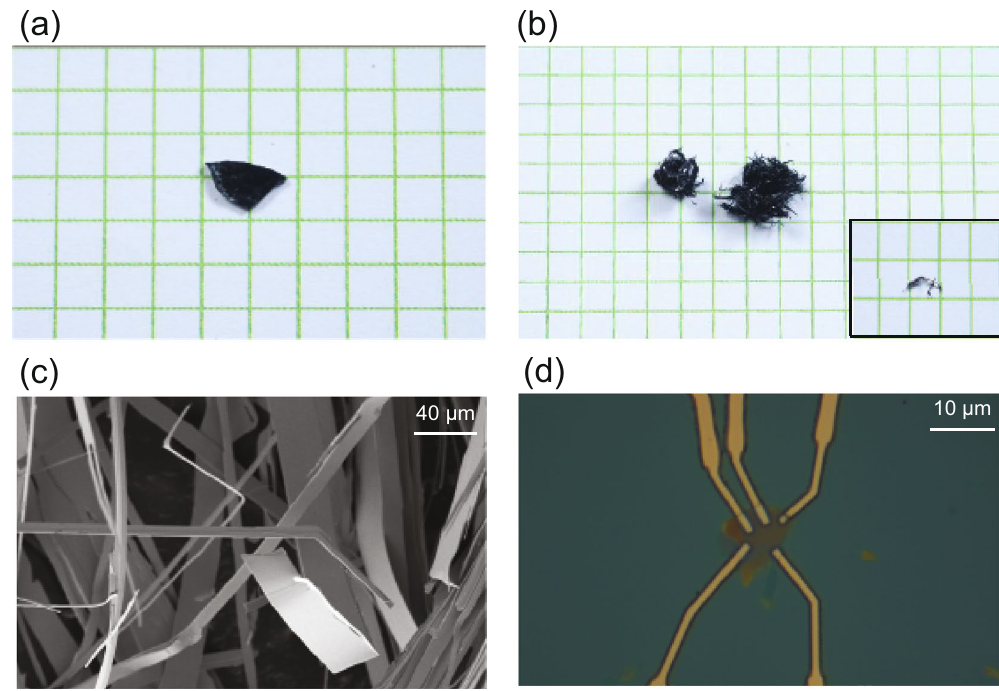
Figure 1. Growth of BSCCO whiskers. ( a ) Photograph of an amorphous BSCCO shard. ( b ) Photograph of grown whiskers on the shard following the annealing. (Inset) Single whisker. Scale - 1 sq. grid = 1 cm 2 . ( c ) SEM image of grown whiskers. ( d ) Optical image of device fabricated to measure electronic properties of exfoliated BSCCO thin flakes